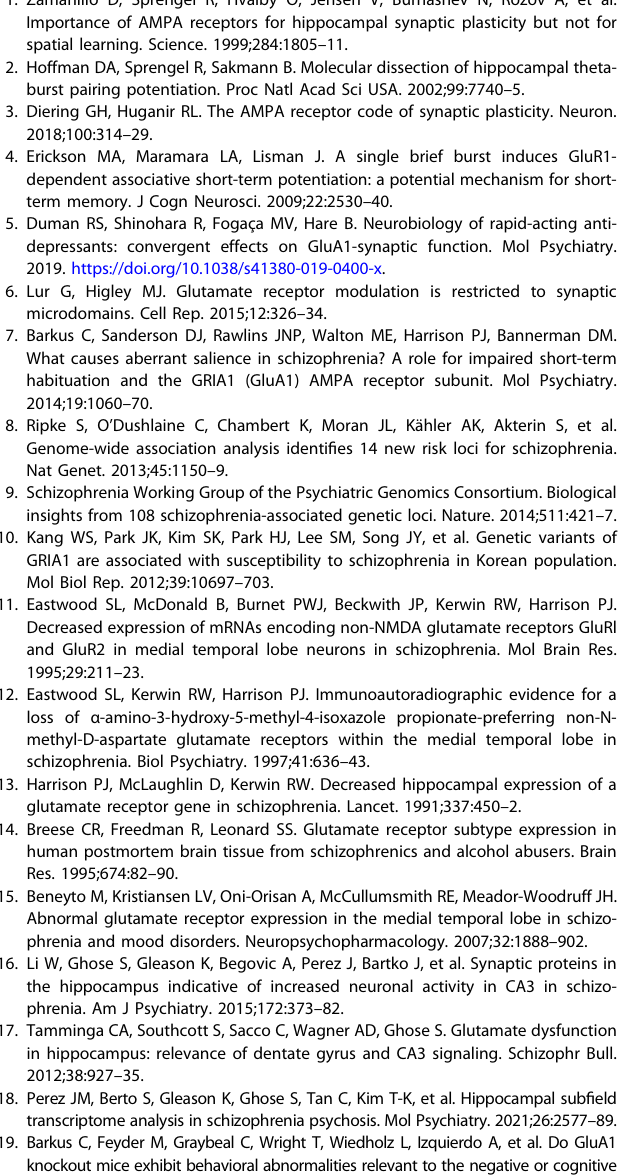
(Fig. 2a), the mosaic and time-dependent distribution of Amigo2 expression during development [37], and the dependence of the stochastic Cre-lox-recombination on the distance between lox- sites [59] which is smaller in typical fl uorescent reporter lines (e.g., 838 bp in the widely used Ai9 and Ai14 tdTomato Cre-reporter lines [60]) than in the fl oxed Gria1 line (1628 bp) [35].